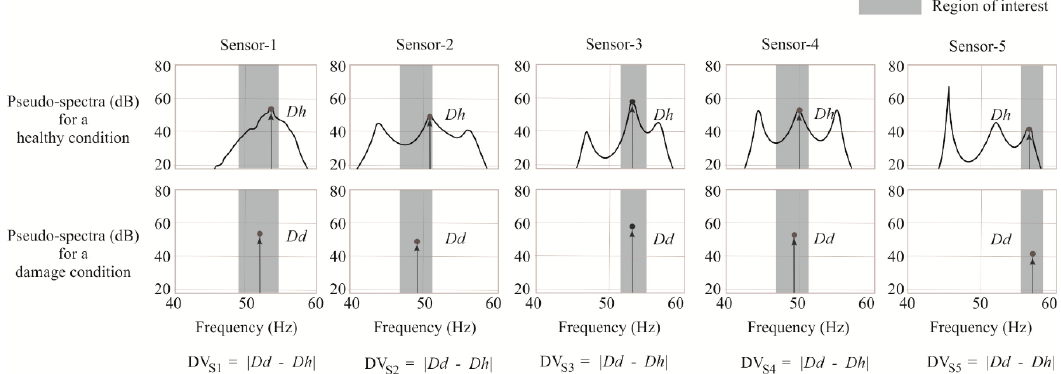
Figure 9. Pseudo-spectra analyses for DV computation and, consequently, damage location.